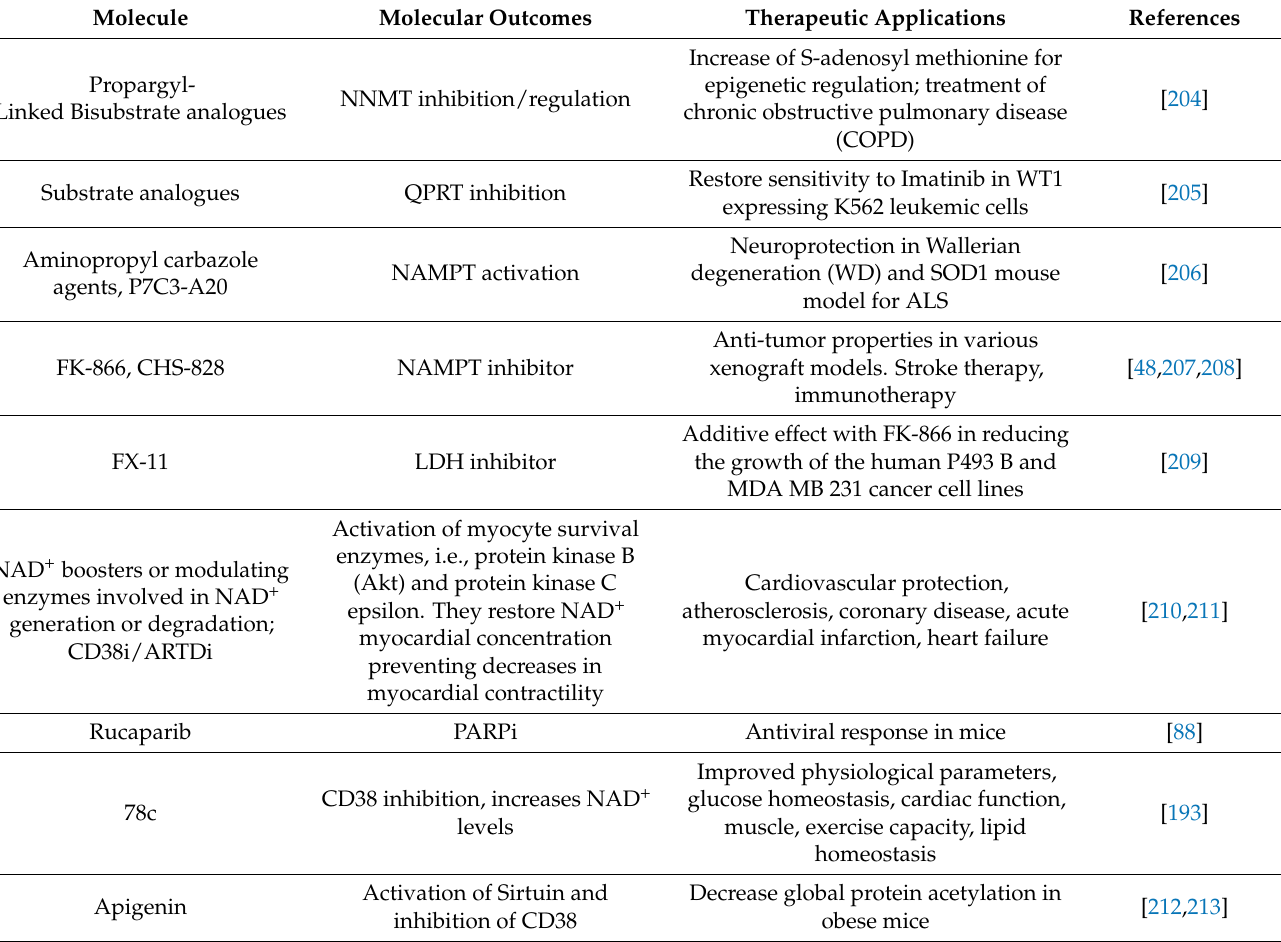
Table 5. Drugs regulating NAD+ synthesis and other enzymes in disease treatment and in combined therapies.